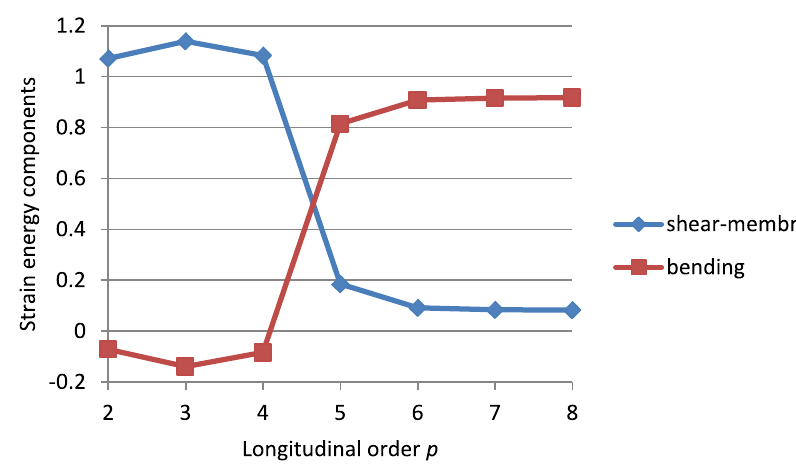
Figure 6. The global energy—the bending-dominated